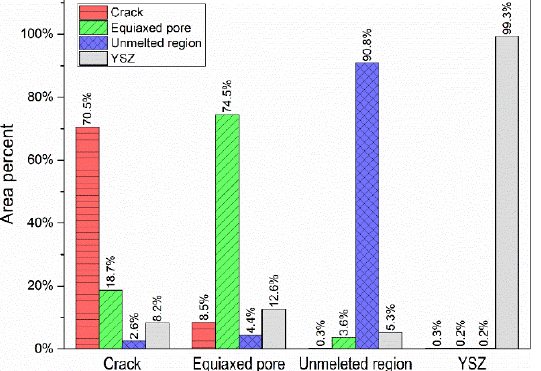
Figure 15. Predicted amount each class of microstructure in a hypothetical image containing all 57 test images.